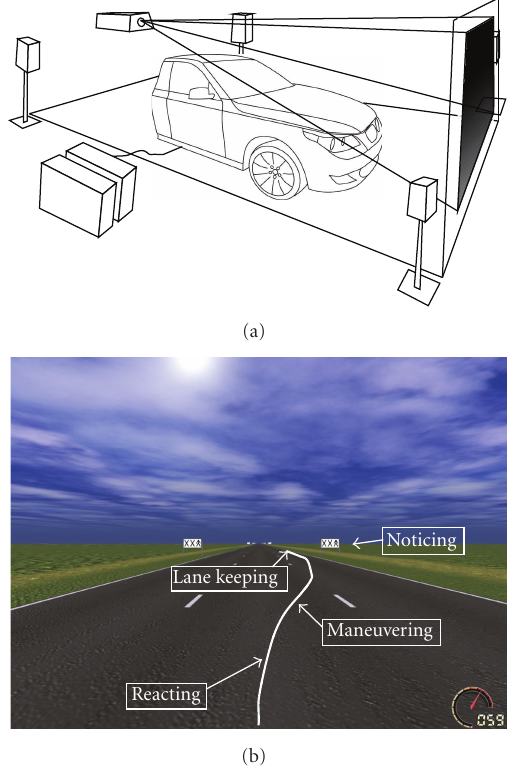
Figure 1: Driving simulator and simulation software. (a) Setup of the driving simulator. (b) Lane-Change-Task (the signs indicate that a lane change is to be